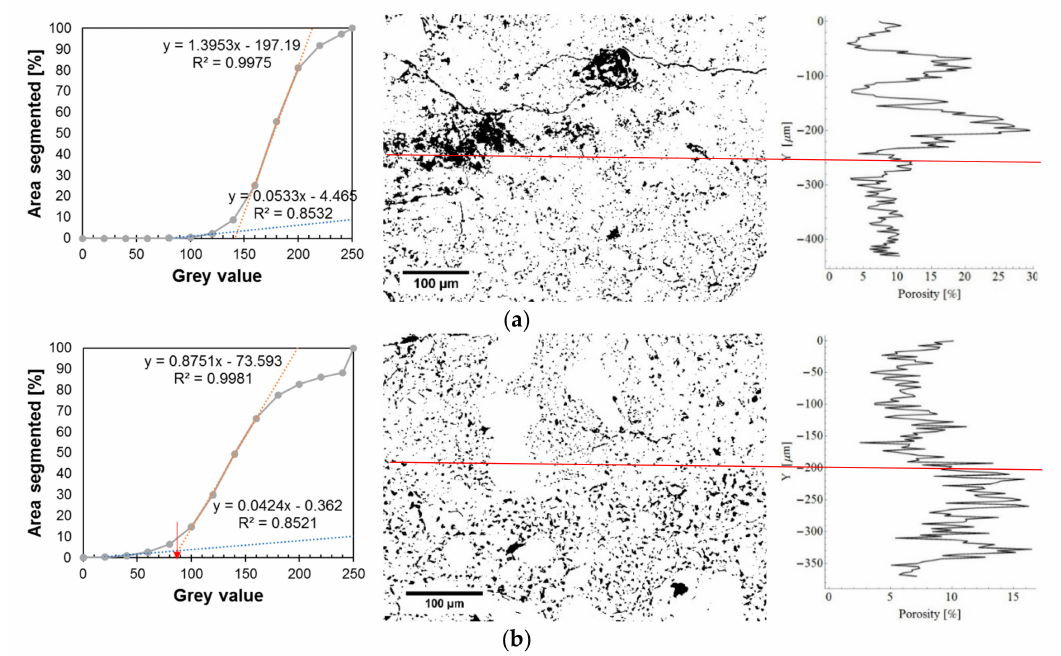
Figure 12. Exemplary cumulative gray scale histograms, images of segmented pores and charts of the fractional share of pores along the thickness of the interphase zone for the mortar: ( a ) without Al 2 O 3 nanopowder; ( b ) modified with the addition of 0.5% of Al 2 O 3